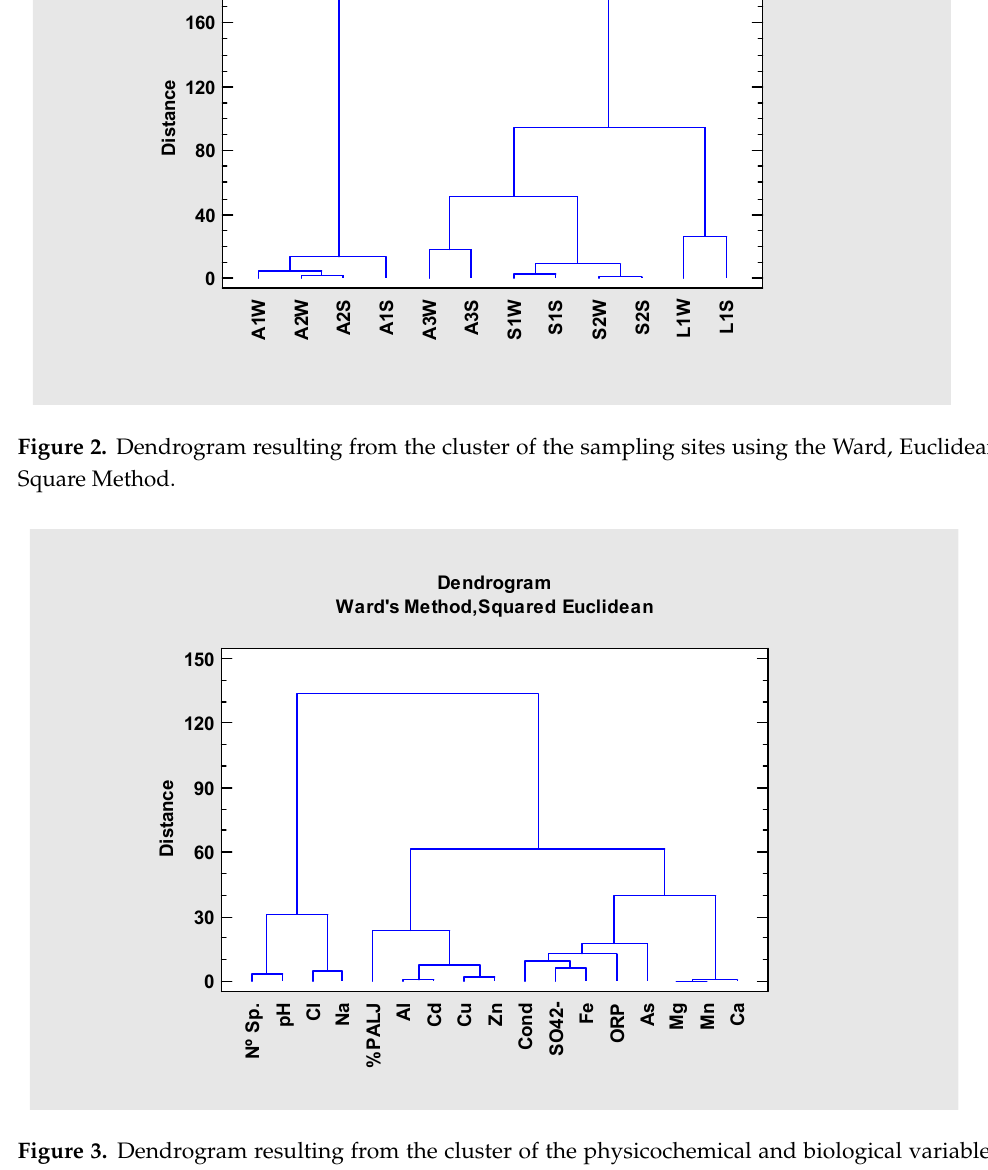
Figure 2. Dendrogram resulting from the cluster of the sampling sites using the Ward, Euclidean Square Method.